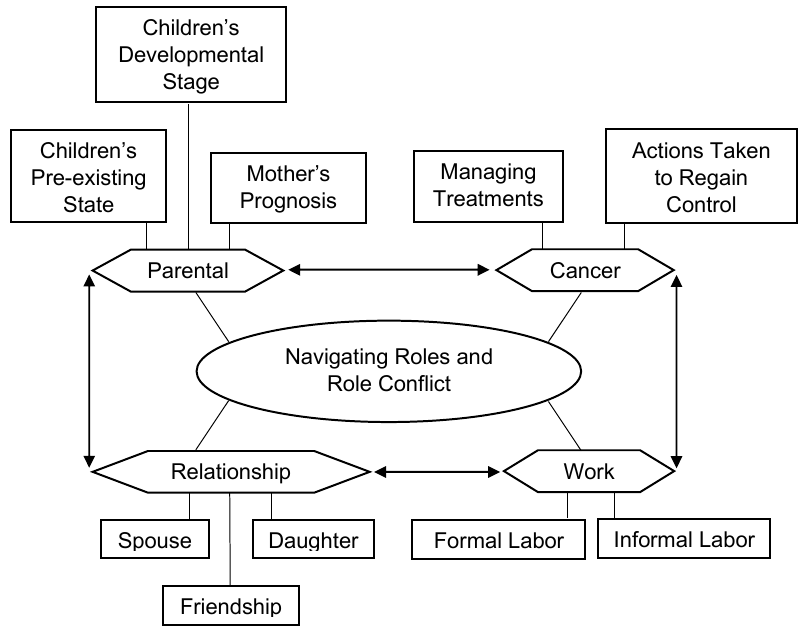
Figure 2. Visual map of Theme 1 by codes. Note. A line indicates that one component is a factor of another, and two arrows indicate a bidirectional in fl uence.